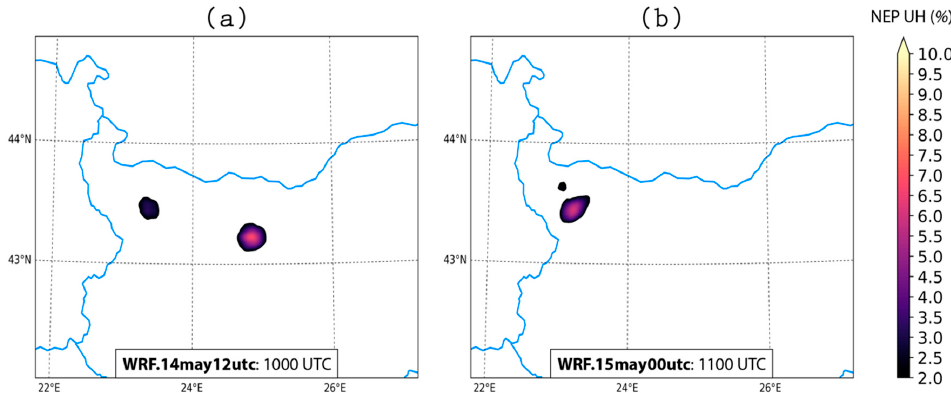
Figure 12. Comparing the NEP values of hourly-maximum 2–5 km UH exceeding 100 m 2 s − 2 associated with ( a ) WRF.14may12utc and ( b ) WRF.15may00utc for two different forecast times (10:00 UTC and 11:00 UTC, respectively).